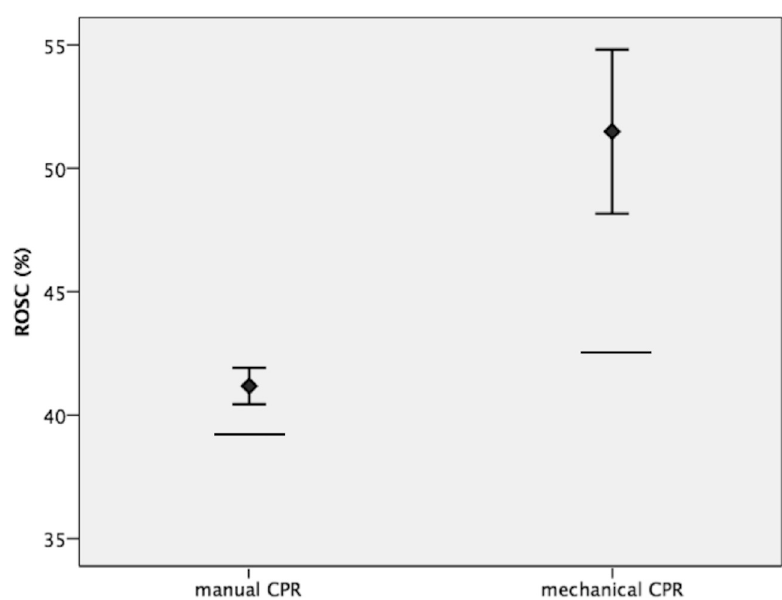
Fig 3. Expected (bar) and observed (diamond; antennas display 95% confidence interval with small bars imaging upper and lower bound) ROSC rates (%). ROSC = return of spontaneous circulation; CPR = cardiopulmonary